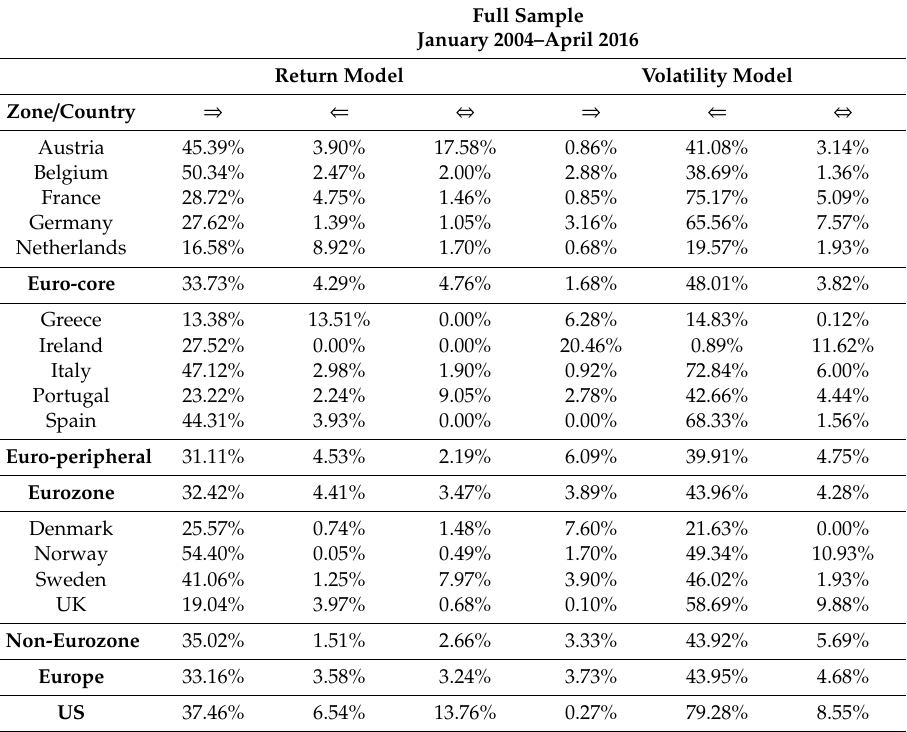
Table 6. Granger causality test results: bank indices and bank CDS